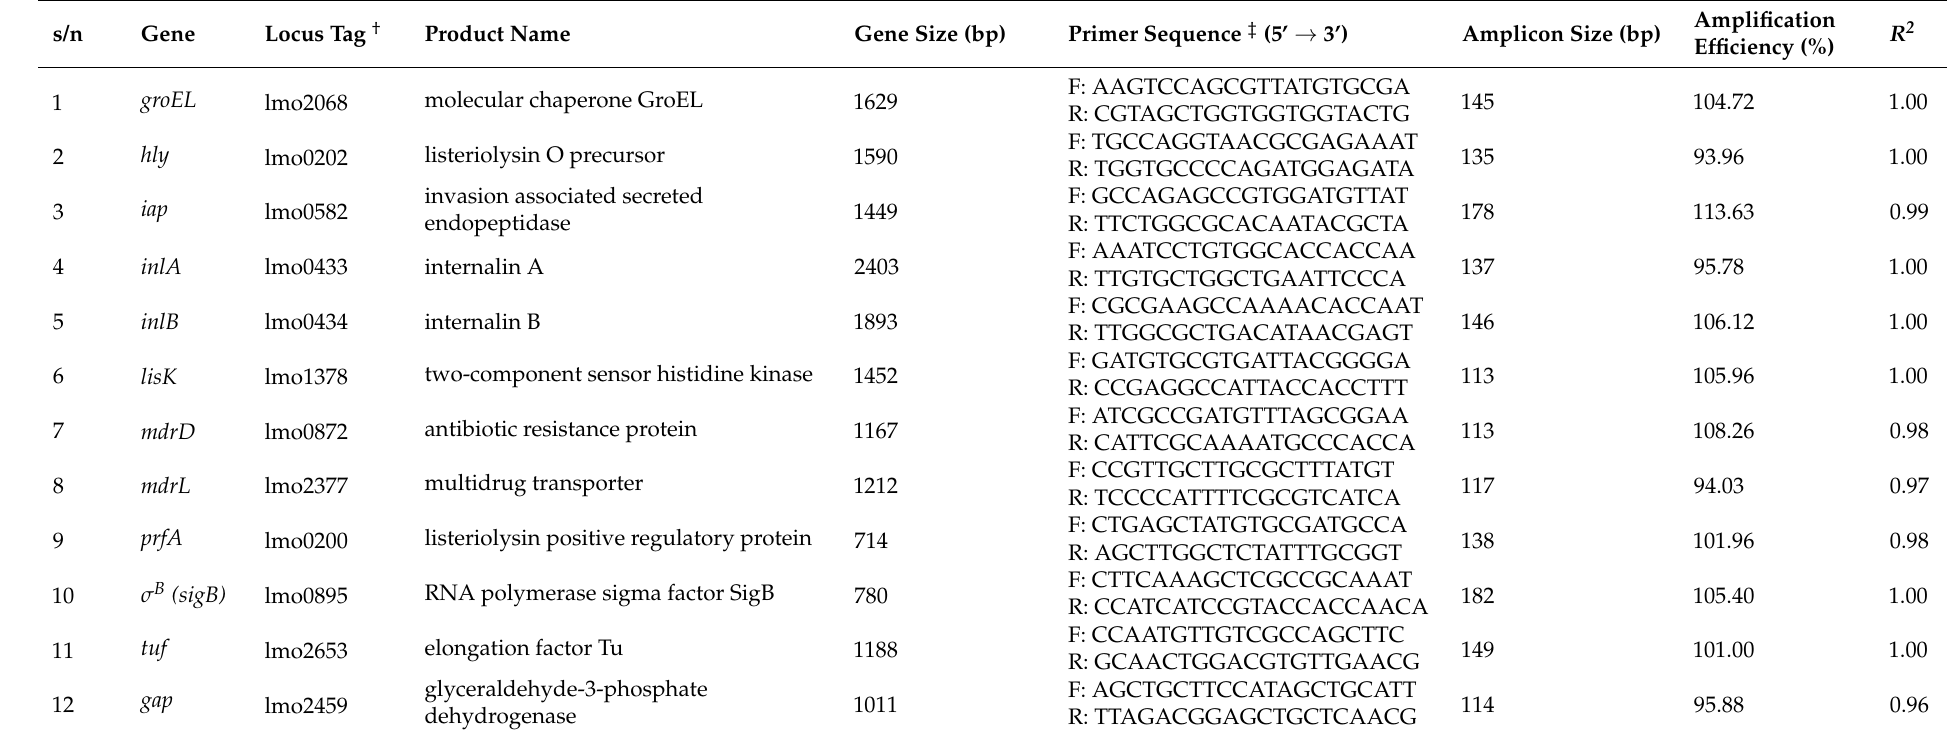
Table 1. Sequences of the primers used for the in vitro quantitation of the mRNA transcripts of the ten target genes ( groEL, hly, iap, inlA, inlB, lisK, mdrD, mdrL, prfA, sigB ) and the two reference genes ( tuf , gap ). The amplicon size (bp) and amplification efficiency (%) of each primer pair, together with the regression coefficients ( R 2 ) of the linear standard curves constructed for the determination of each PCR efficiency, are also